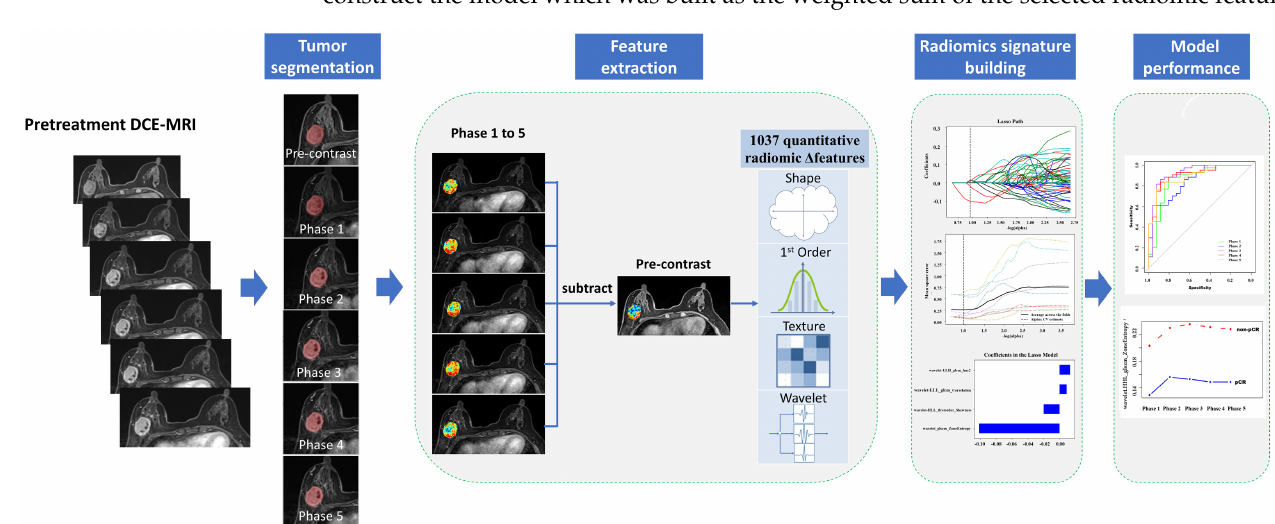
Figure 1. The workflow of the